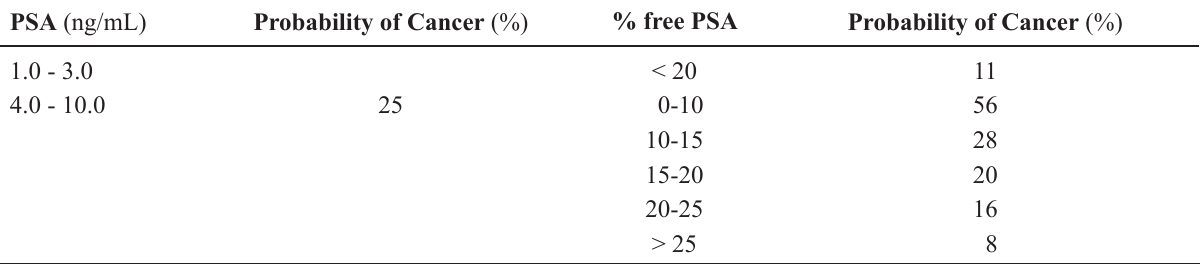
Table 3 – Probability of cancer based on PSA and percentage of free PSA. PSA